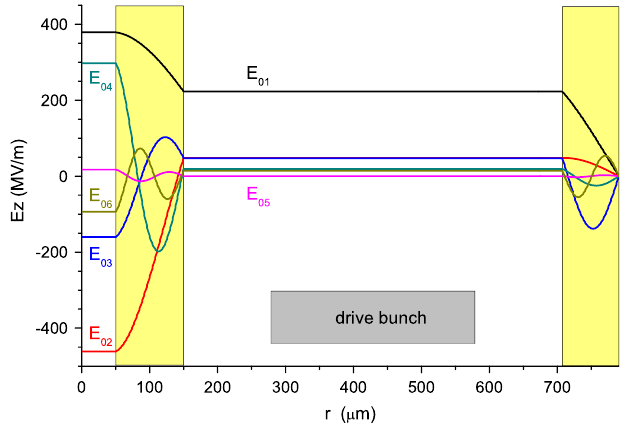
FIG. 13. (Color) Transverse profiles E z ð r Þ for the first six TM modes. Radii of the inner dielectric shell are 50 and 150 (cid:1) m , radii of the outer dielectric shell are 707.5 and 790 : 5 (cid:1) m . Locations of the two dielectric shells are highlighted in yellow, and location and width of the 5-GeV drive bunch is shown in